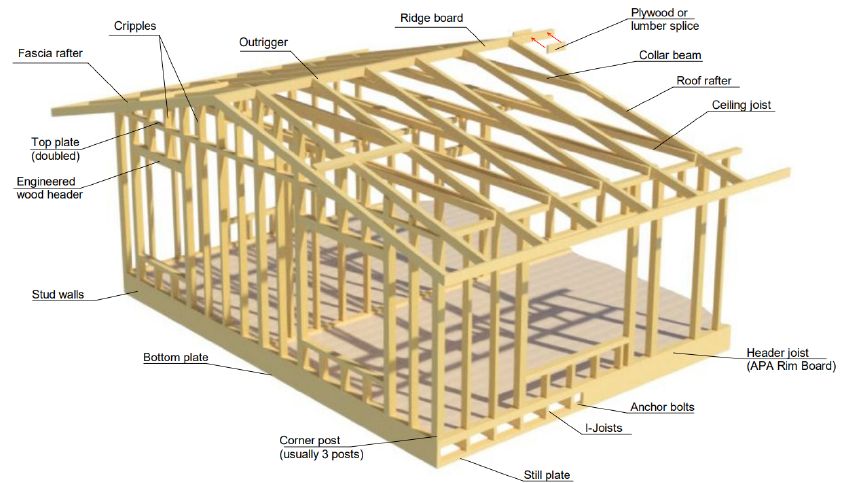
Figure 10. Components of a frame wall.